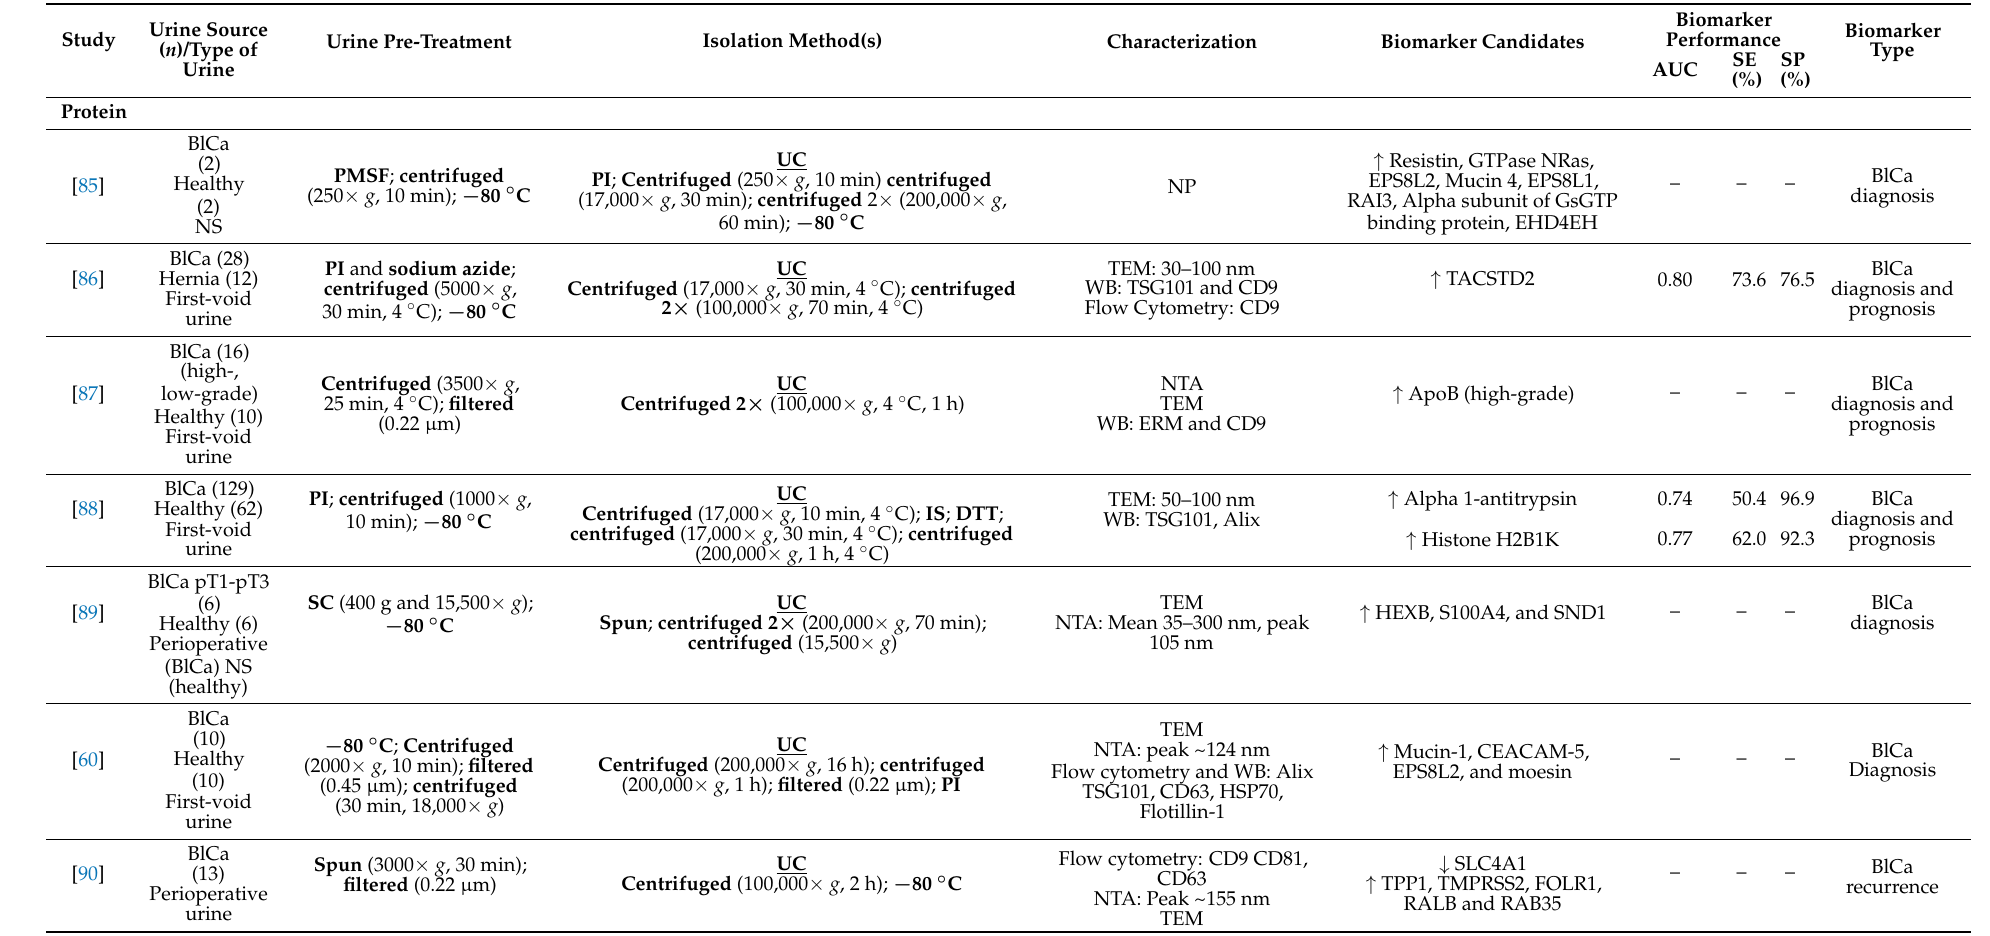
Table 3. uEV-derived protein and miRNA biomarker candidates in bladder cancer